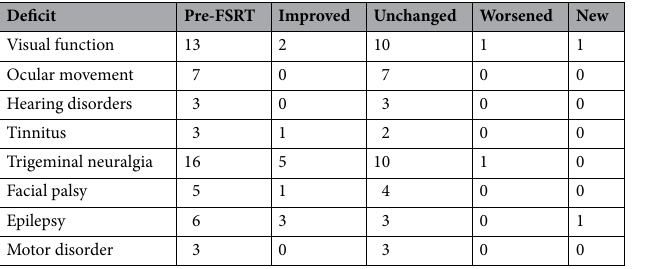
Table 3. A Summary changes in neurological deficits after FSRT. FSRT fractionated stereotactic radiotherapy.